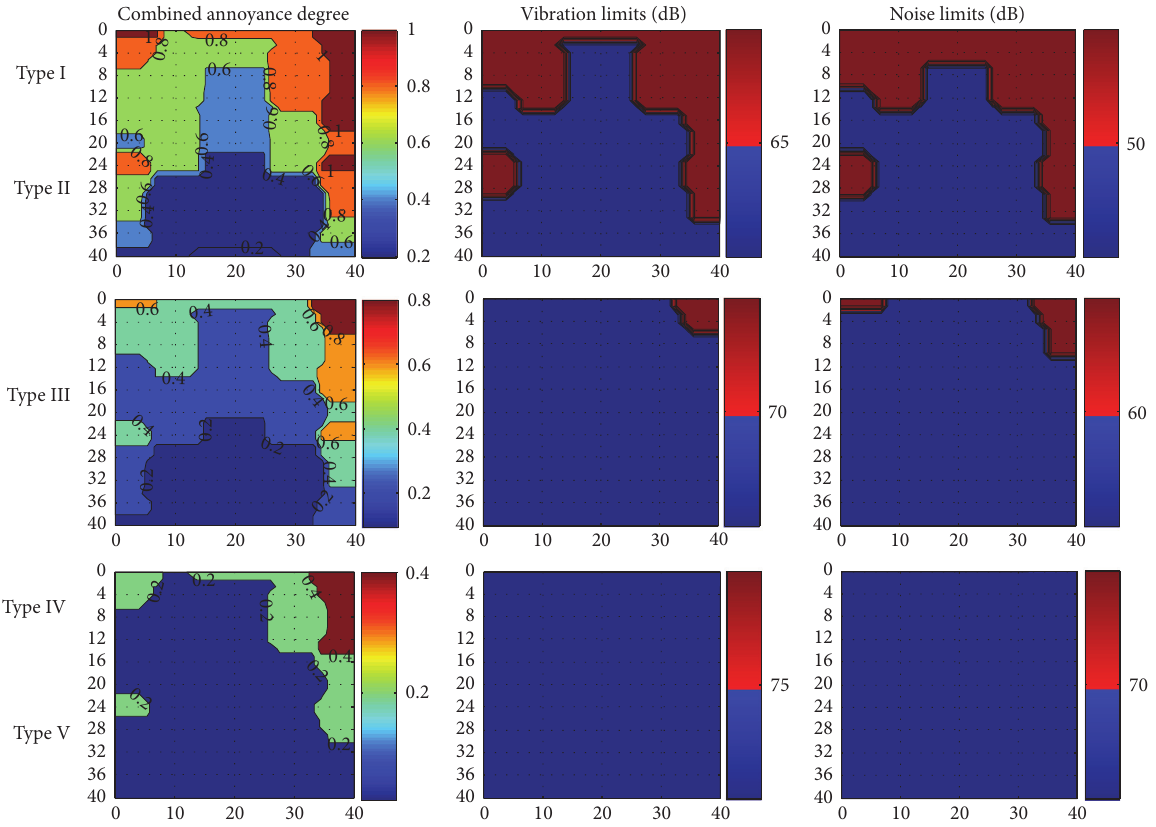
Figure 12: Assessment results